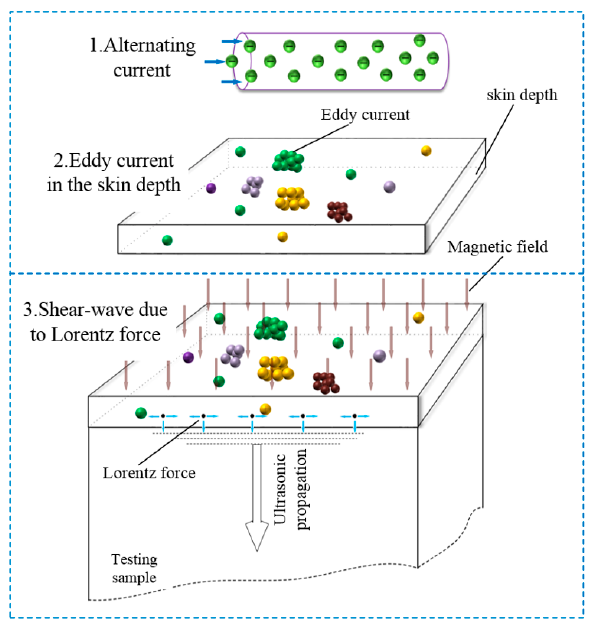
Figure 1. Schematic of electromagnetic-acoustic conversion.